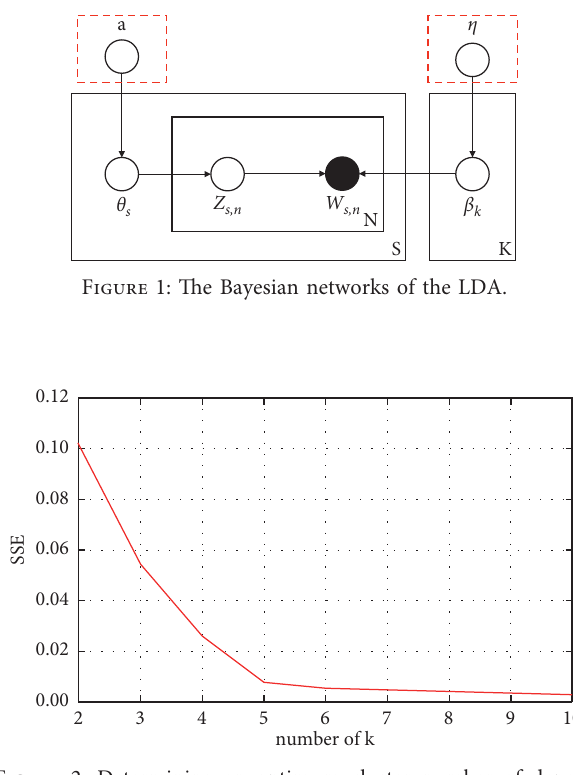
Figure 2: Determining an optimum cluster number of depen- dencies based on the SSE